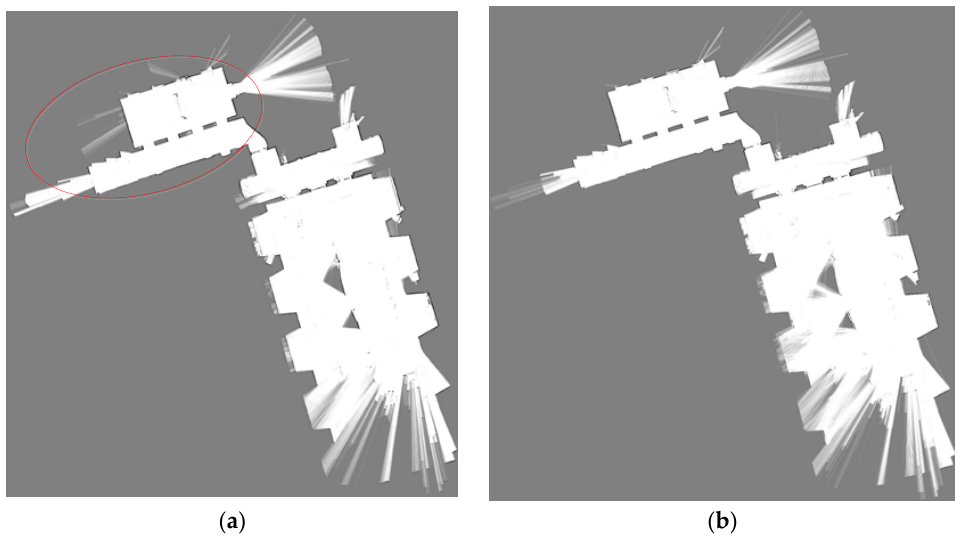
Figure 14. Map built by Cartographer (LiDAR only) ( a ) and the proposed method ( b ) with file b0-2014-08-14-13-36-48.bag [48].